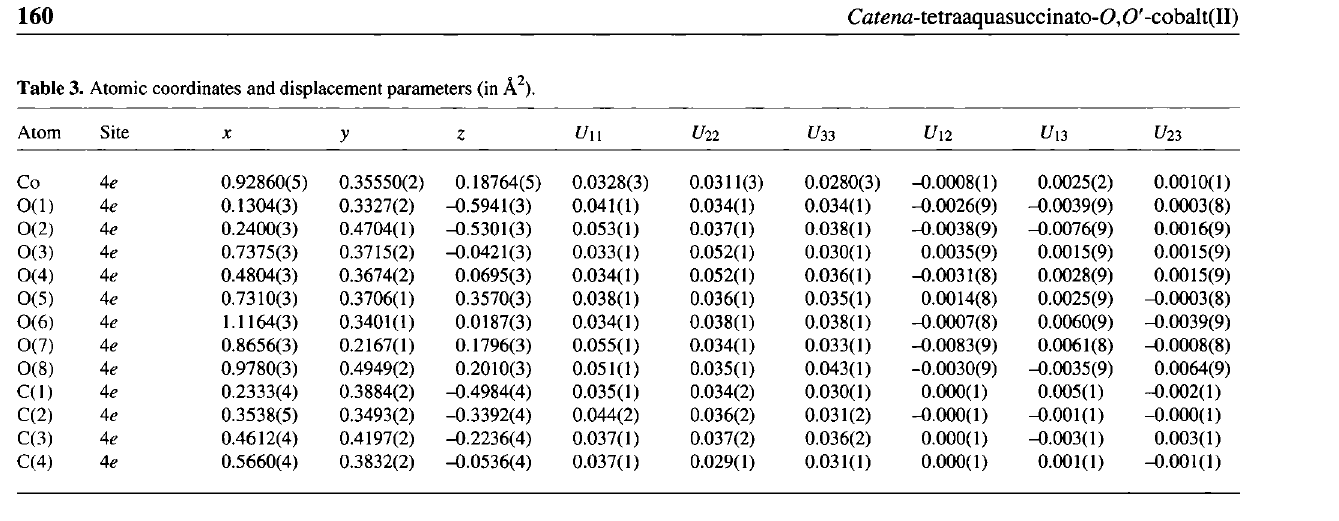
Table 3. Atomic coordinates and displacement parameters (in Ä 2